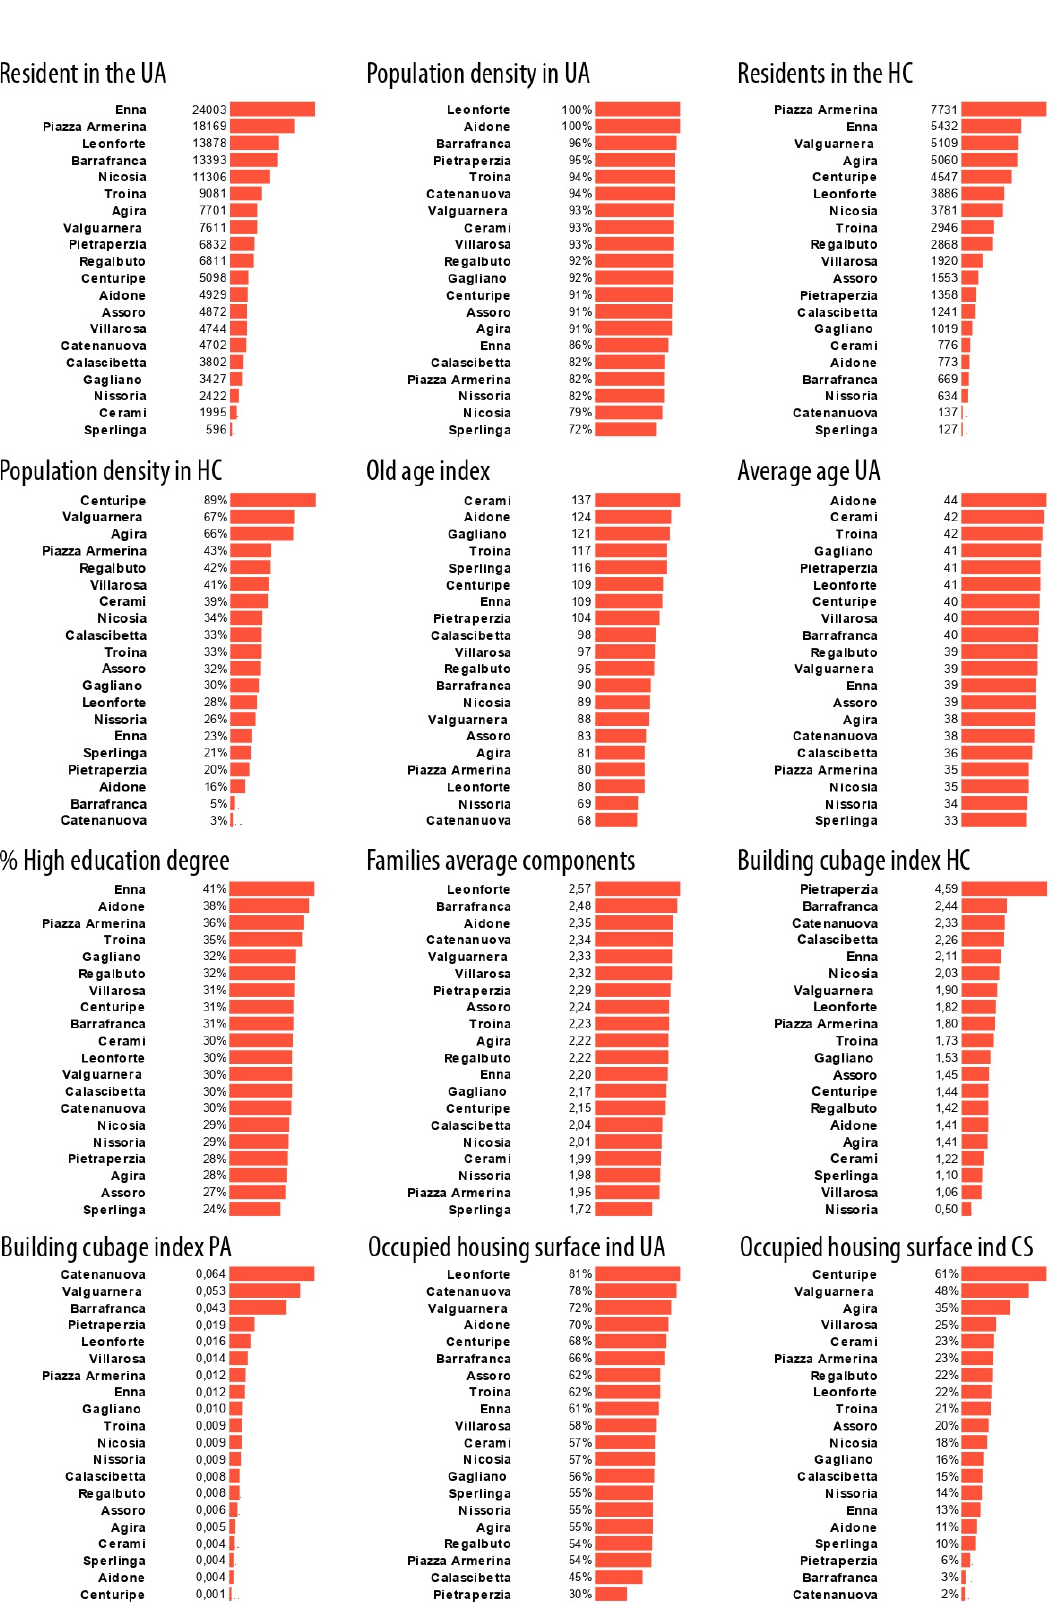
Figure 2. Rankings of the Municipalities from the perspective of the location territorial equilibrium indices.